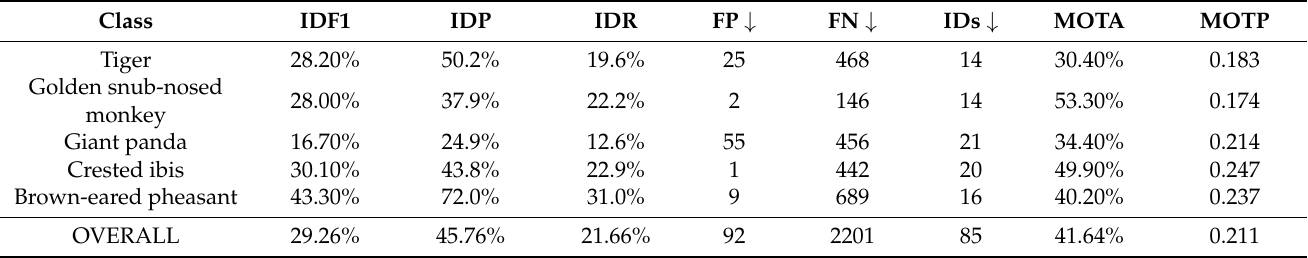
Table A2. Results of the same few-shot object detector in our model combined with SORT tracker on the MOT-EA dataset.